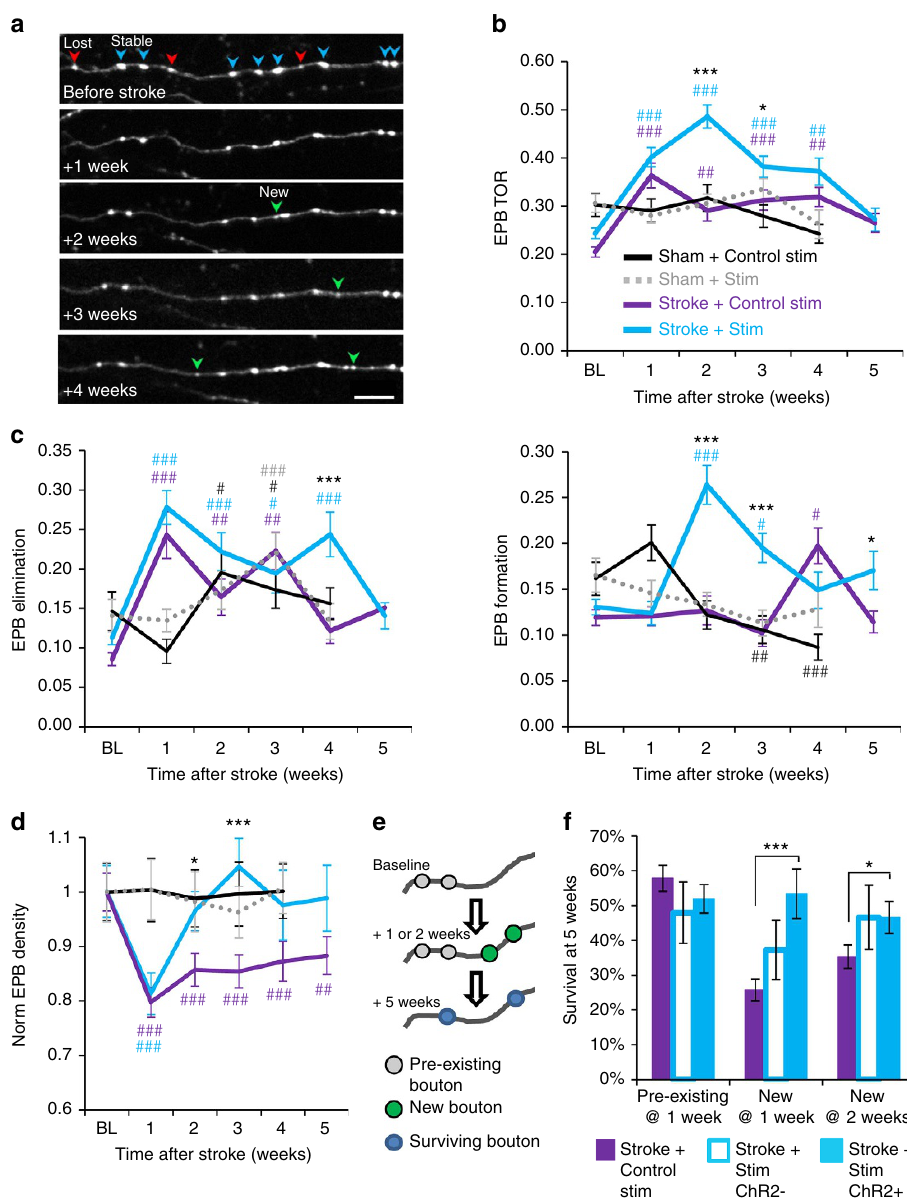
Figure 5 | Optogenetic stimulation promotes the formation of new and stable thalamocortical boutons. ( a ) Time lapse in vivo images showing the formation and elimination of thalamocortical EPBs over several weeks following stroke. Blue arrowheads ¼ stable EPB, red arrowhead ¼ lost EPB, green arrowhead ¼ new EPB. ( b ) EPB TOR in mice with sham stroke (with control stimulation: n ¼ 5 mice, 125 axons, 1,001 EPBs at BL; or ChR2 stimulation: n ¼ 6 mice, 110 axons, 1,243 EPBs at BL), stroke with optogenetic stimulation ( n ¼ 9 mice, 101 axons, 2,423 EPBs at BL) or those with control stimulation ( n ¼ 6 mice, 90 axons, 1,477 EPBs at BL). ( c ) Graph plotting the fraction of EPB eliminated or formed each week. ( d ) Graph plotting the density of thalamocortical EPBs normalized to BL values. ( e ) Cartoon summary of our analysis of EPB survival rates (blue boutons that were present at 1, 2 weeks and 5 weeks) based on whether an EPB was preexisting (grey) or newly formed (green) at 1 or 2 weeks post stroke. ( f ) Histogram showing the survival (at 5 weeks post stroke) of preexisting versus newly formed EPB in axons from mice that received control stimulation (purple), or ChR2 negative (open teal bars) or positive axons (filled teal bars) from mice that received optogenetic stimulation. Data are means ± s.e.m. # P o 0.05, ## P o 0.01, ### P o 0.001 based on t -tests comparing post-stroke time points in each group designated by colour to respective BL values. * P o 0.05, ** P o 0.01, *** P o 0.001 based on t -tests comparing stroke þ stimulation versus stroke þ control stimulation. Scale bar, ( a ) 10 m